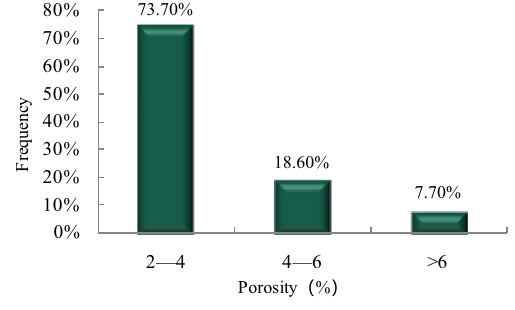
Fig. 3 Comparison of conductivity of acid-etched fractures with different acid types